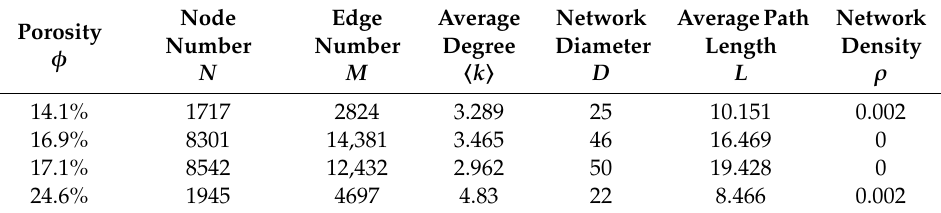
Table 1. Basic parameters of sandstone networks.